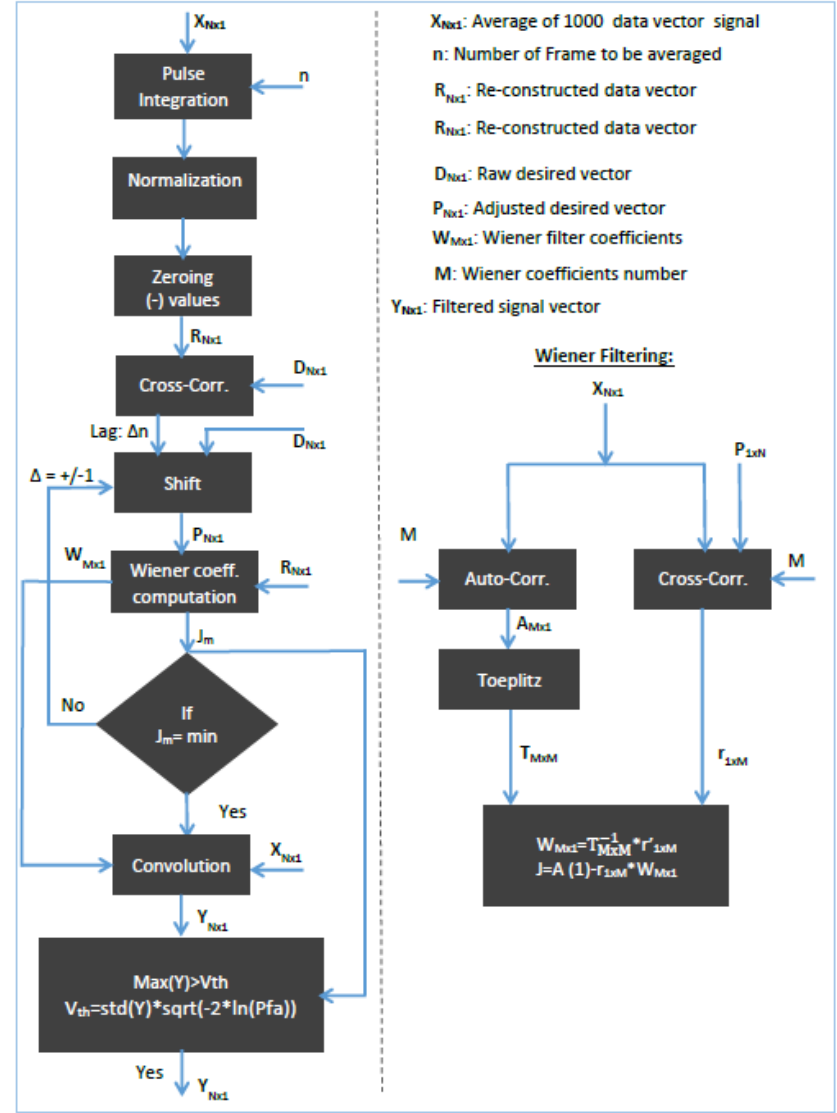
Figure 6. Algorithm used to extract the signal buried in noise. The data acquired (X Nx1 ) contains 4096 points and data interval corresponds to 10 ns duration. This corresponds to the maximum distance that can be measured is 6144 m. D Nx1